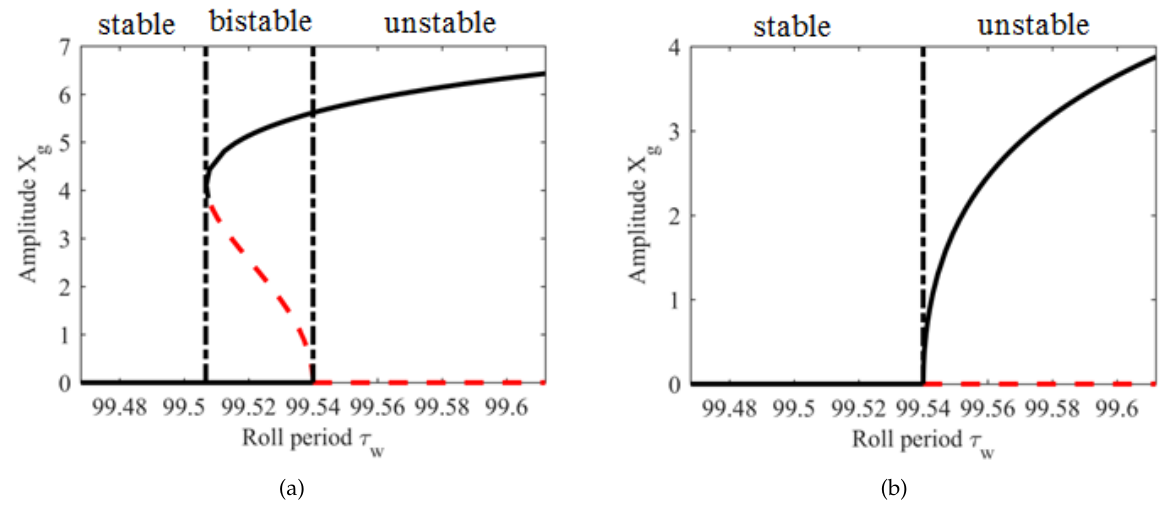
Fig. 10. Bifurcation diagrams: (a) subcritical Hopf bifurcation when a small control is introduced, and (b) super Hopf bifurcation when a big control is introduced